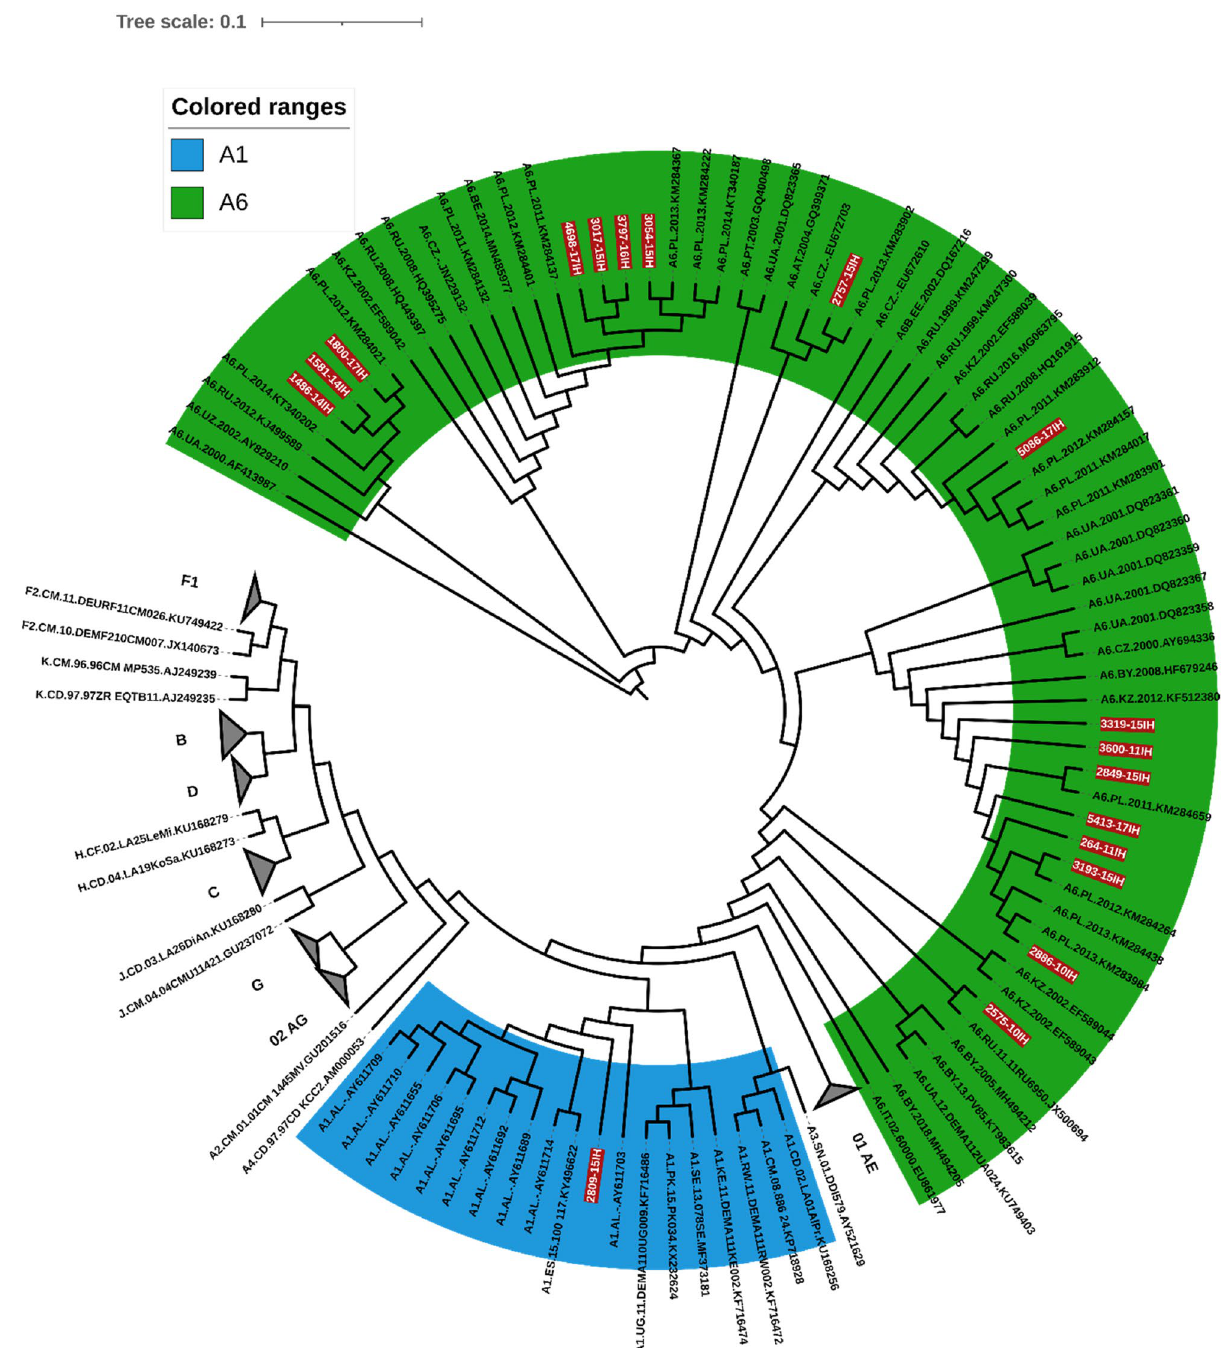
Figure 1. Maximum likelihood tree showing the subtype A identification with the reference sequences from HIV sequence compendium supplemented with A1 and A6 sequences from GenBank. A1 variant is colored in blue, A6 in